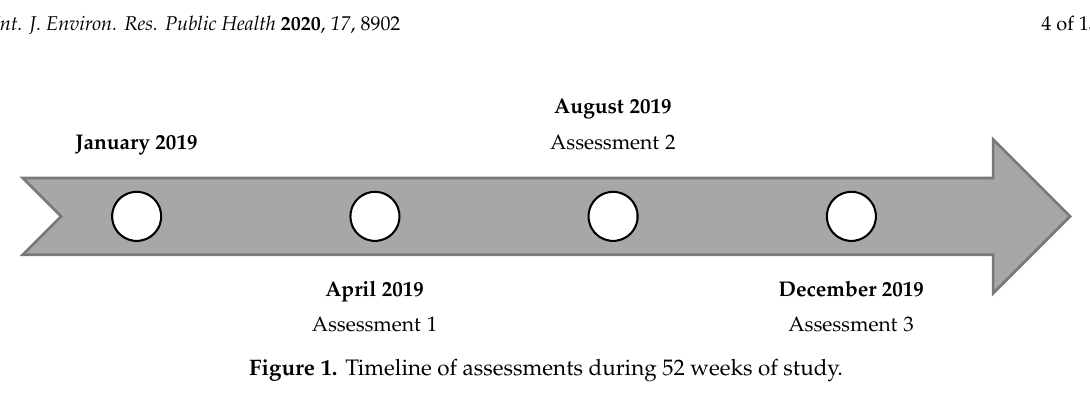
Figure 1. Timeline of assessments during 52 weeks of study.